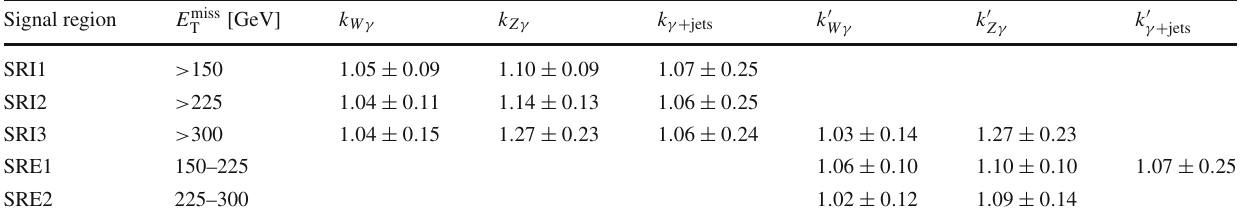
Table 3 Normalisation factors (scale factors k ) obtained from a background-only inclusive-SR fit performed in each inclusive SR (the first three columns) and scale factors k (cid:7) obtained from a background- only multiple-bin fit performed simultaneously in the three regions